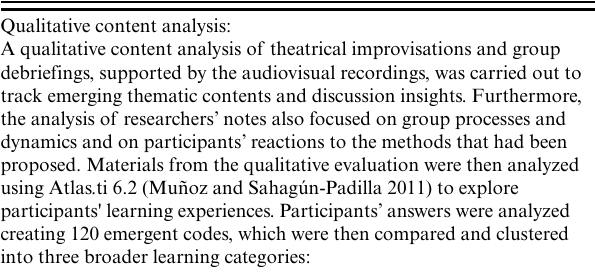
Table 3 . Analysis